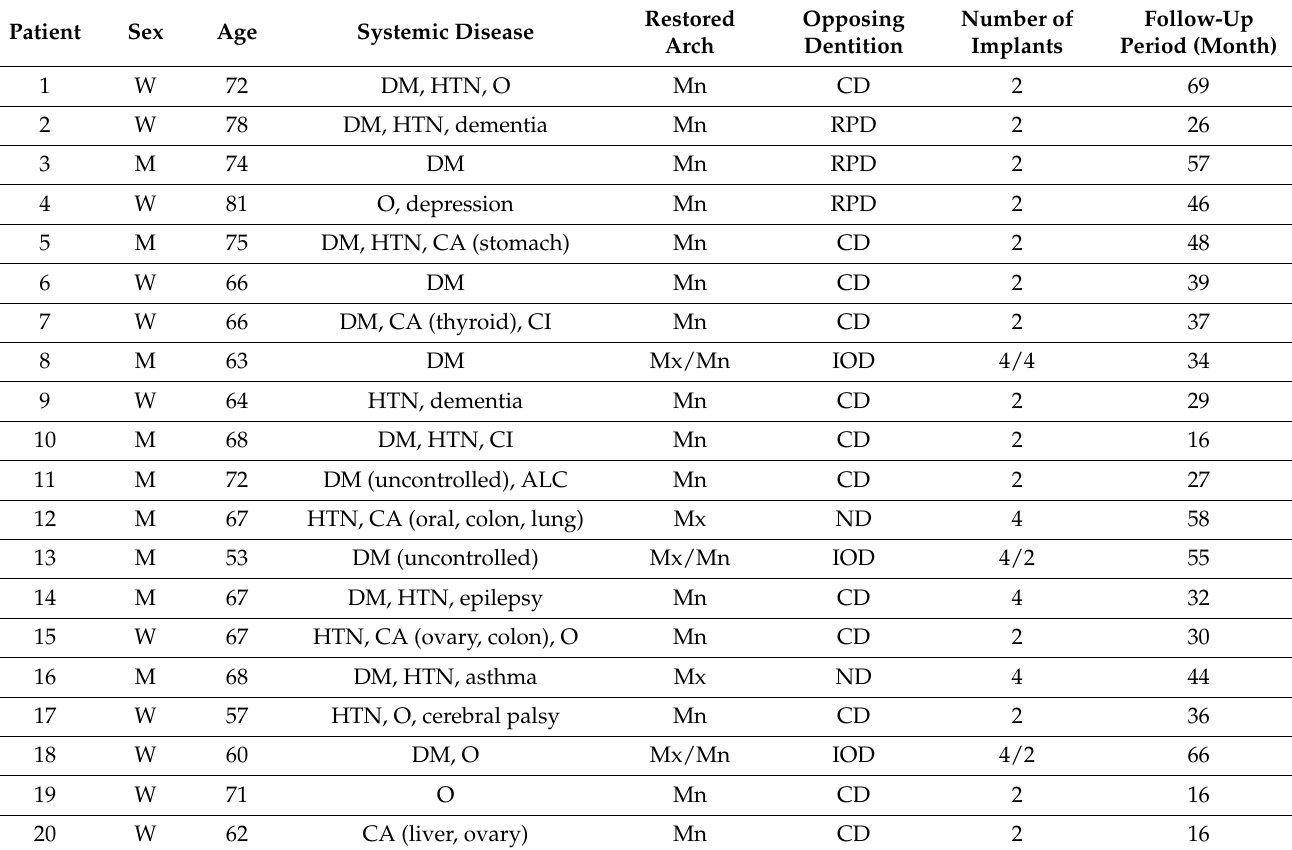
Table 1. Baseline characteristics of patients and